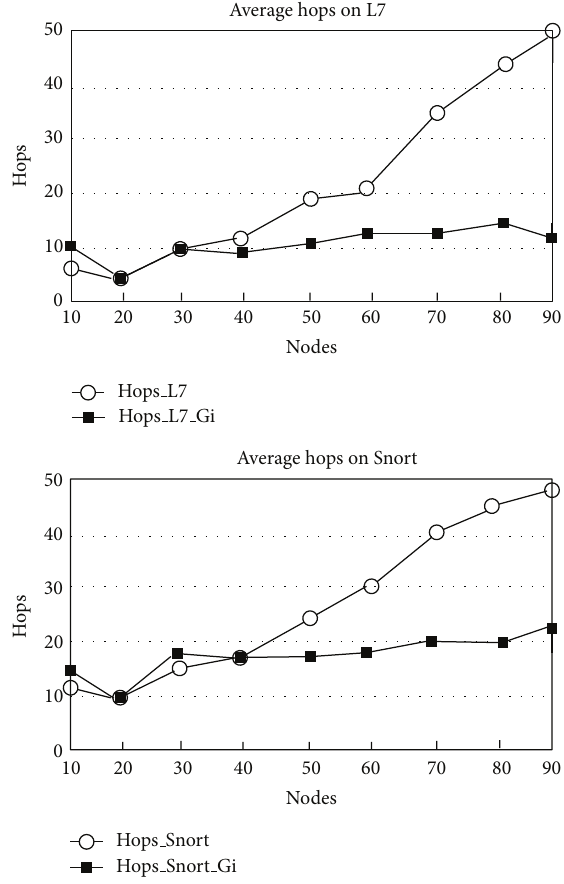
Figure 7: Results of node average hops in